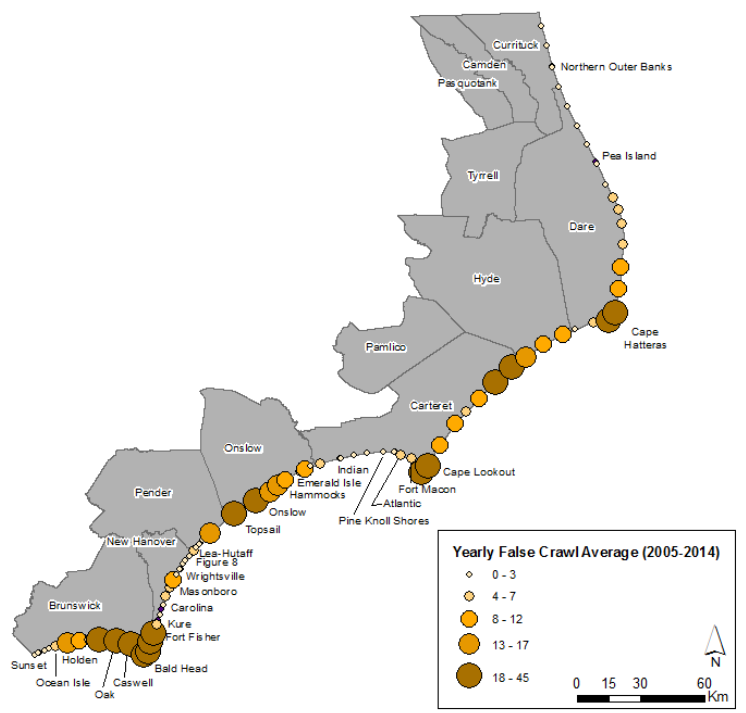
Figure 6. Average yearly number of false crawls, by transect polygon (2005–2014).